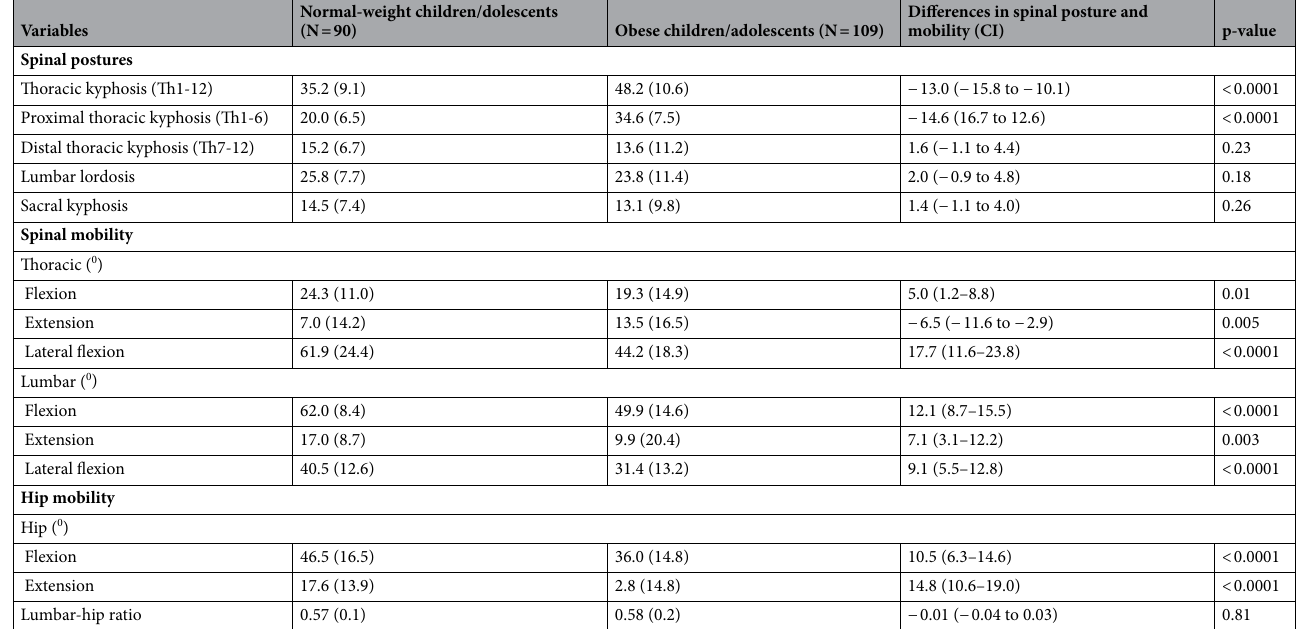
Table 2. Participants’ characteristics, spinal postures, lumbar, thoracic and hip mobility differences between the normal-weight and obese groups (mean ± standard deviations). p-value—statistical significance for comparison between the two groups. CI confidence interval. Lumbar–hip ratio (during trunk flexion in the sagittal plane) = lumbar range of motion/(lumbar range of motion + hip range of